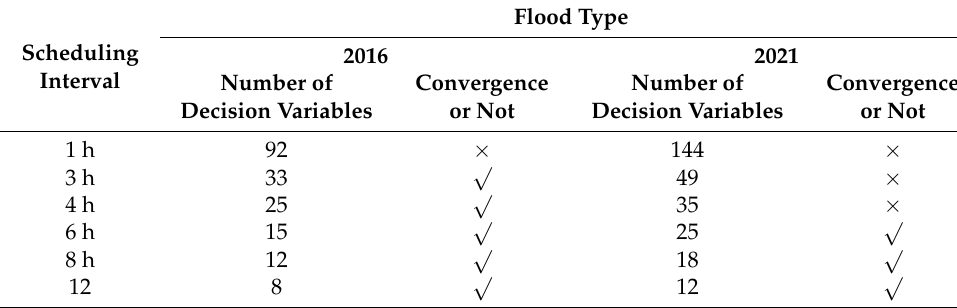
Table 2. Difficulty analysis of flood problem with different dispatching time intervals.